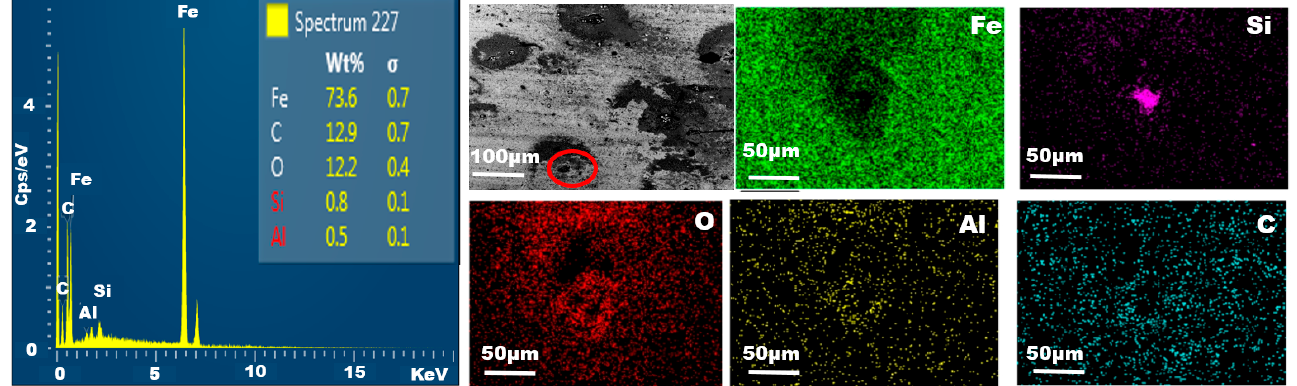
Figure 12. EDS spectra and elemental mapping after erosion in 90° elbow .